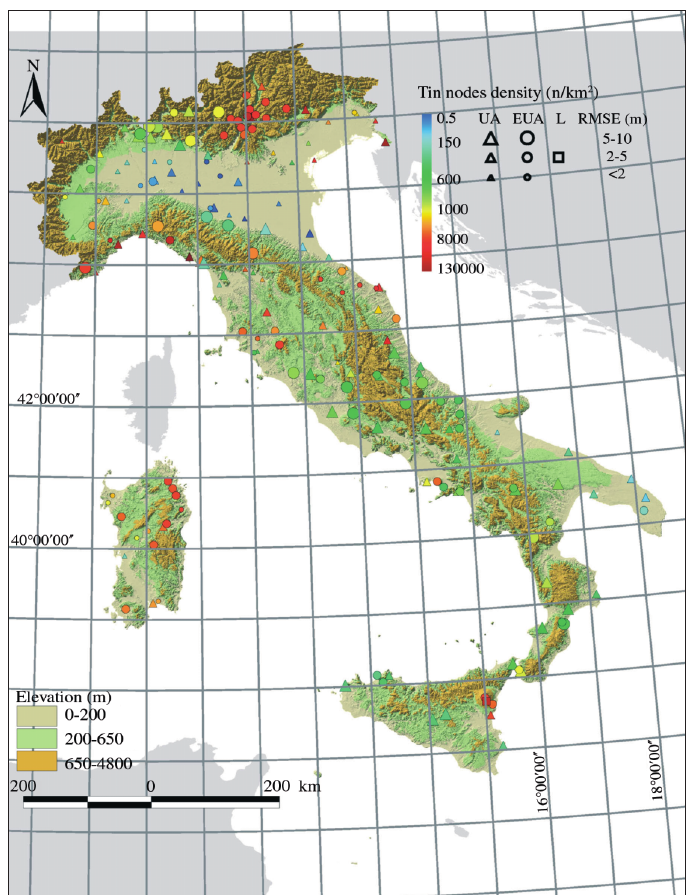
Fig. 7. Vertical accuracies of TINITALY/01 plotted over a shaded relief image of Italy. Estimates were done by using control point sets in Extra Urban Areas (EUA, circles), Urban Areas (UA, triangles) and LiDAR (L, squares). Colors represent the local TIN nodes density, increasing from blue to red. The size of the symbols re- late to the vertical accuracy of the TINITALY/01 elevations, according to the top-right legend of the